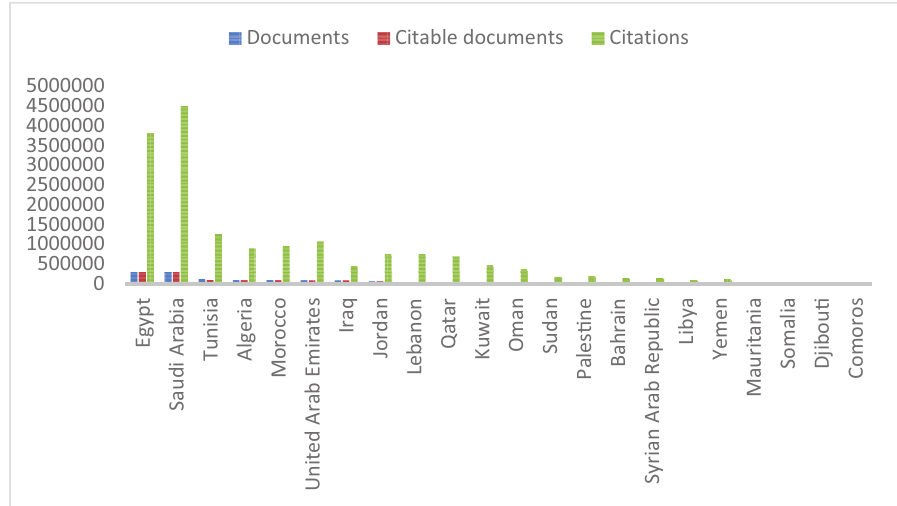
Figure 2 : Number of documents, citable documents, and citations published in 1996–2021 by the Arab countries (based on Scopus data as of April